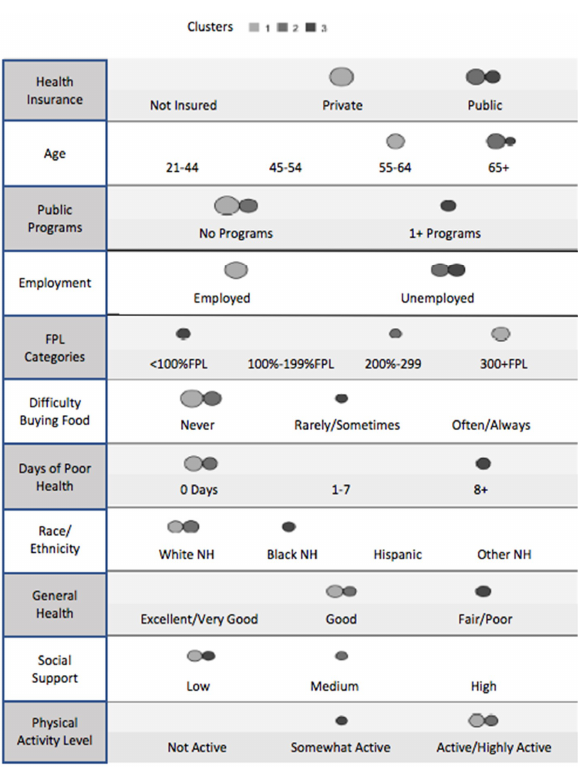
Figure 1. Cluster comparison describing the proportion of respondents for each indicator within a cluster. FPL—Federal Poverty Level, an economic measure used to decide if household members (based on household income and number of persons) qualify for a range of federal programs in the U.S.; NH—Non-Hispanic. Circle size corresponds to the proportion of cases that fit that indicator for each cluster. Table 1. Description of indicator categories within each cluster (unweighted